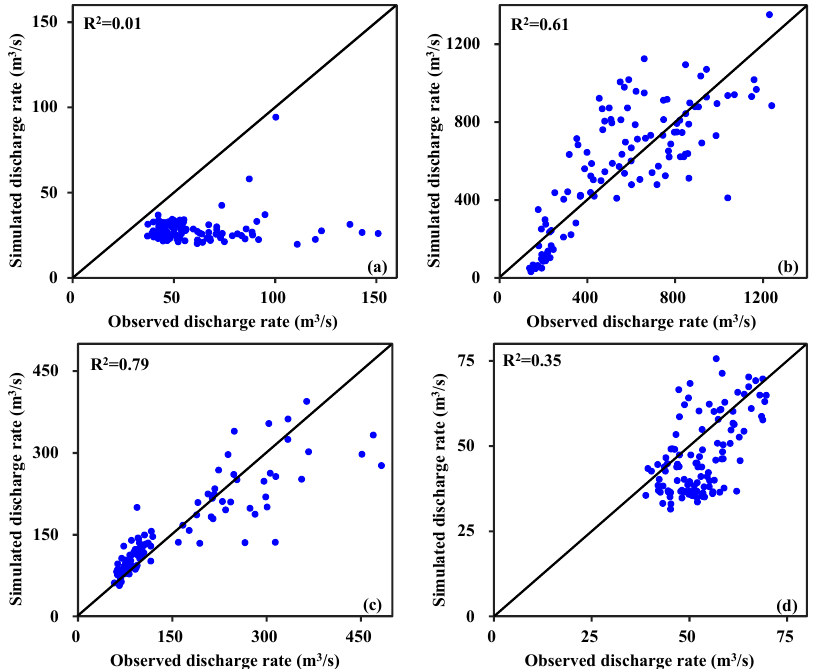
Figure 5. Coefficient of determination ( R 2 ) for overall period at seasonal statistics by monthly results; ( a ) Spring (March–May); ( b ) Summer (June–August); ( c ) Autumn (September–November); ( d ) Winter (December–February).